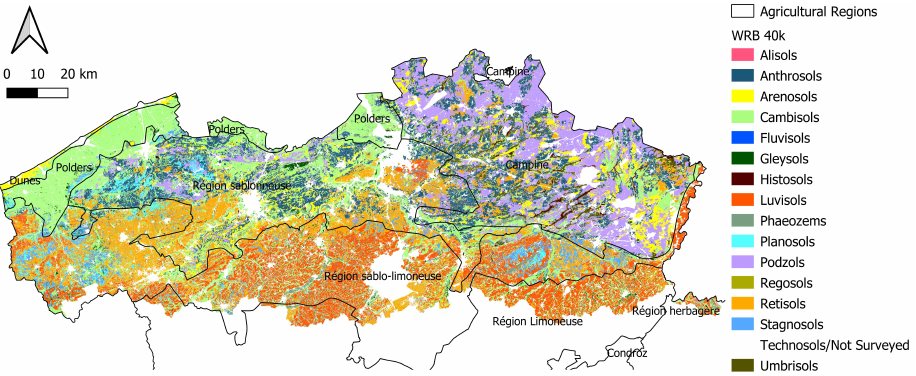
Figure 2. Reference soil groups in Flanders (data source: [32]).